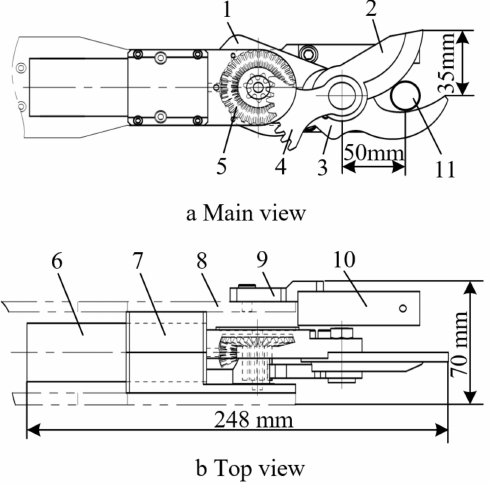
Figure 4. The structural diagram of the end-effector. 1. Fixed base; 2. Moving cutter; 3. Stationary cutter; 4. Incomplete gear mechanism; 5. Bevel gear mechanism; 6. Force motor; 7. Planetary reducer; 8. Forearm; 9. Mounting plate; 10. Diagonal photoelectric sensor; and 11. Branch of the jujube tree. The moving cutter rotated around the hinge point O to shear the jujube branch during the operation. Suppose the blade curve is ˆ ABC , the cutting angle α of any point on the curve is equal to the friction angle ϕ , and the hinge point O is taken as the origin of the coordinates; a coordinate system is established to analyze the blade curve of the moving cutter, as shown in Figure 5.